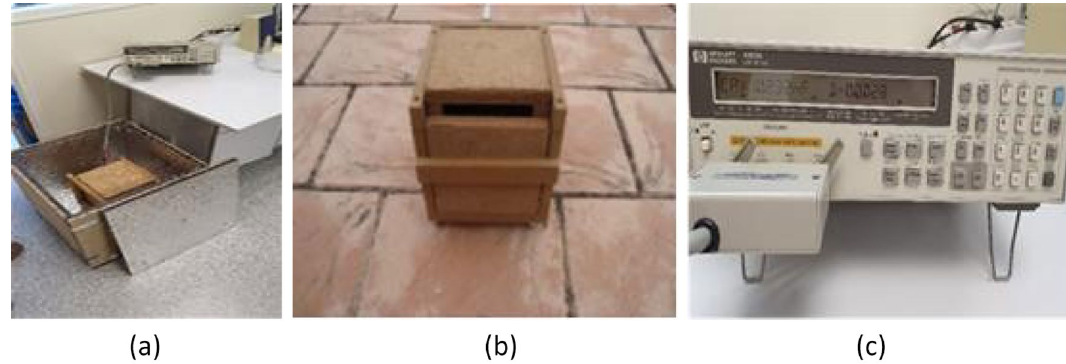
Figure. 1. Inductance measurements inside the interleaving structure: ( a ) external cage contains the intermediate one; ( b ) 0.25 × 0.25 × 0.25 cm 3 cage which contains an even smaller cage, ( c ) LCR measuring